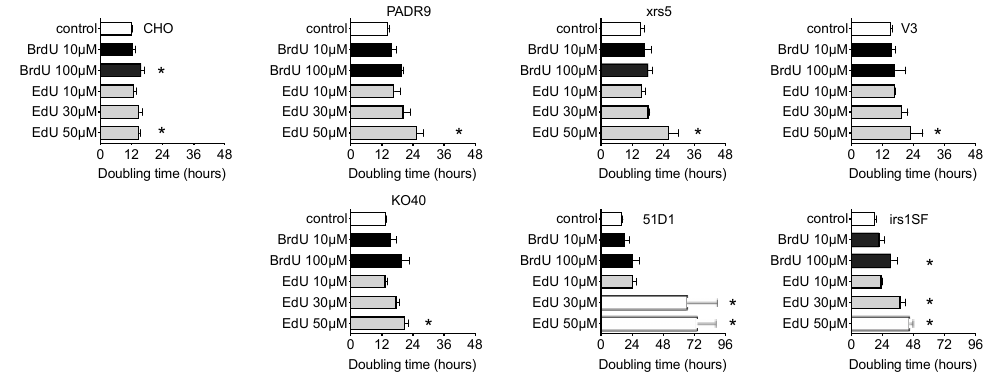
Figure 6. Cell doubling time and growth delay with BrdU and EdU treatment. CHO and DNA repair-deficient cells were grown with or without BrdU or EdU. Open bars indicate control. Black bars indicate BrdU treatment. Grey bars indicate EdU treatment. Error bars represent the standard error of the mean of three independent experiments. One-way ANOVA, Dunnett’s Multiple Comparison Test was performed to provide p -values. (*) denotes significance against control within each cell group ( p < 0.05).